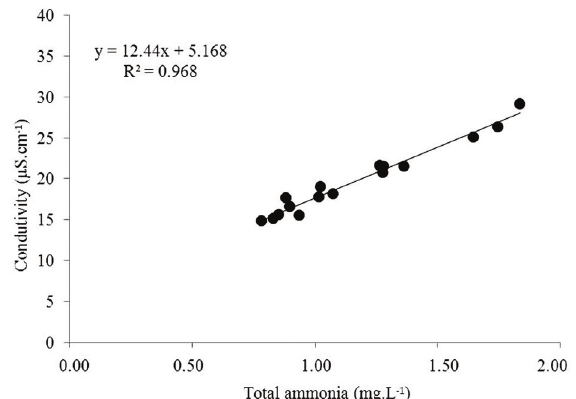
Fig. 1. Correlation between total ammonia (mg.L -1 ) and conductivity ( μ S.cm -1 ) of water after transportation of pencilfish ( Nannostomus trifasciatus ) previously fed with different levels of beta 1,3 glucan.